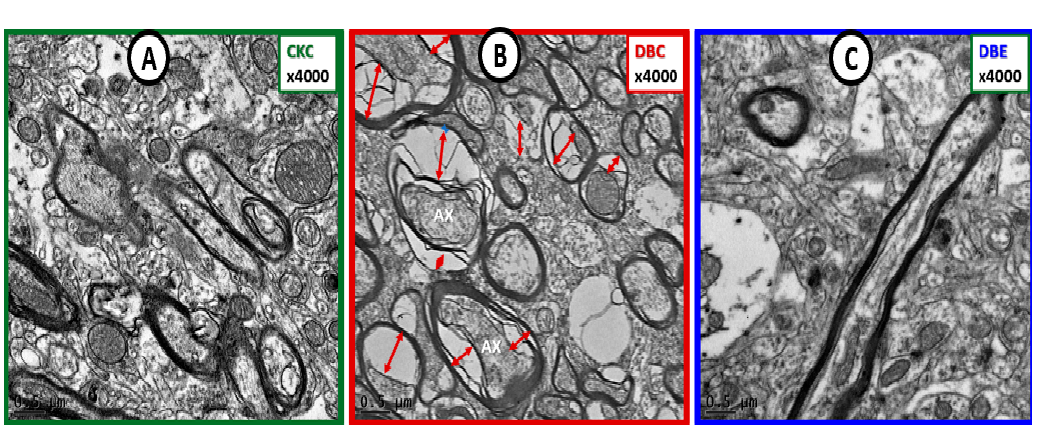
Figure 9. Diabetes-induced axonal collapse was prevented by empagliflozin. Panel ( A ) illustrates the normal morphology of myelinated axons and note the compactness of the myelin lamella. Panel ( B ) depicts multiple myelinated axons with collapsed axoplasm of axons (AX) (red double arrows) as compared to the myelinated neurons in control CKC (panel ( A )). Panel ( C ) demonstrates that empagliflozin treatment protects axons from collapsing and appears similar to CKC in panel ( A ). Magnification 4000×; Bar = 0.5 µm. Ax = axon.